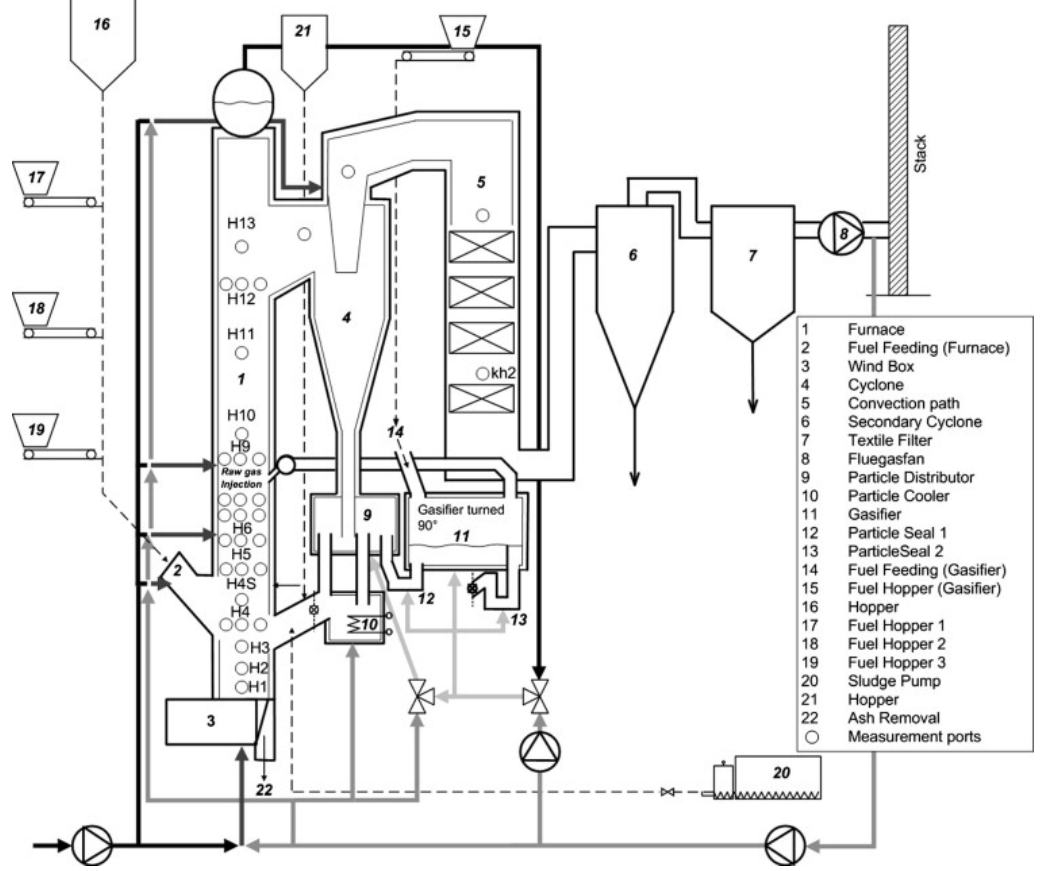
Figure 2. Schematic description of Chalmers Research Boiler/gasifier reactor system.